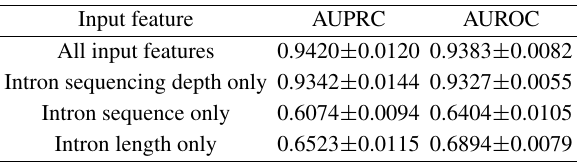
Table 4 Contribution analysis of a single type of feature to IR predictive performance based on the third-generation RNA-seq